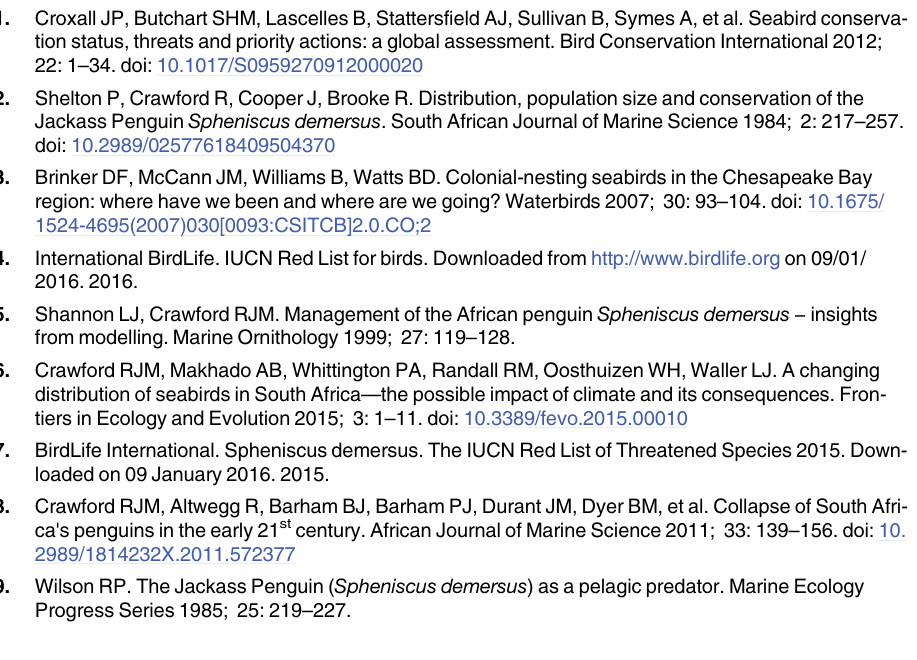
S3 Table. Comparisons in morphometric measurements, body weights, and body condition indices (BCI) of African penguins between sexes and between islands. S4 Table. Carbon and nitrogen stable isotope values and C:N ratios for the five potential prey species included into the Bayesian mixing model MixSIAR. n: number of samples. S5 Table. Stable isotope mixing model (MixSIAR) results with predicted diet proportions (5 th to 95 th percentiles and median values in parentheses) of each five potential prey species compared to δ 13 C and δ 15 N mixture values of the different groups of African